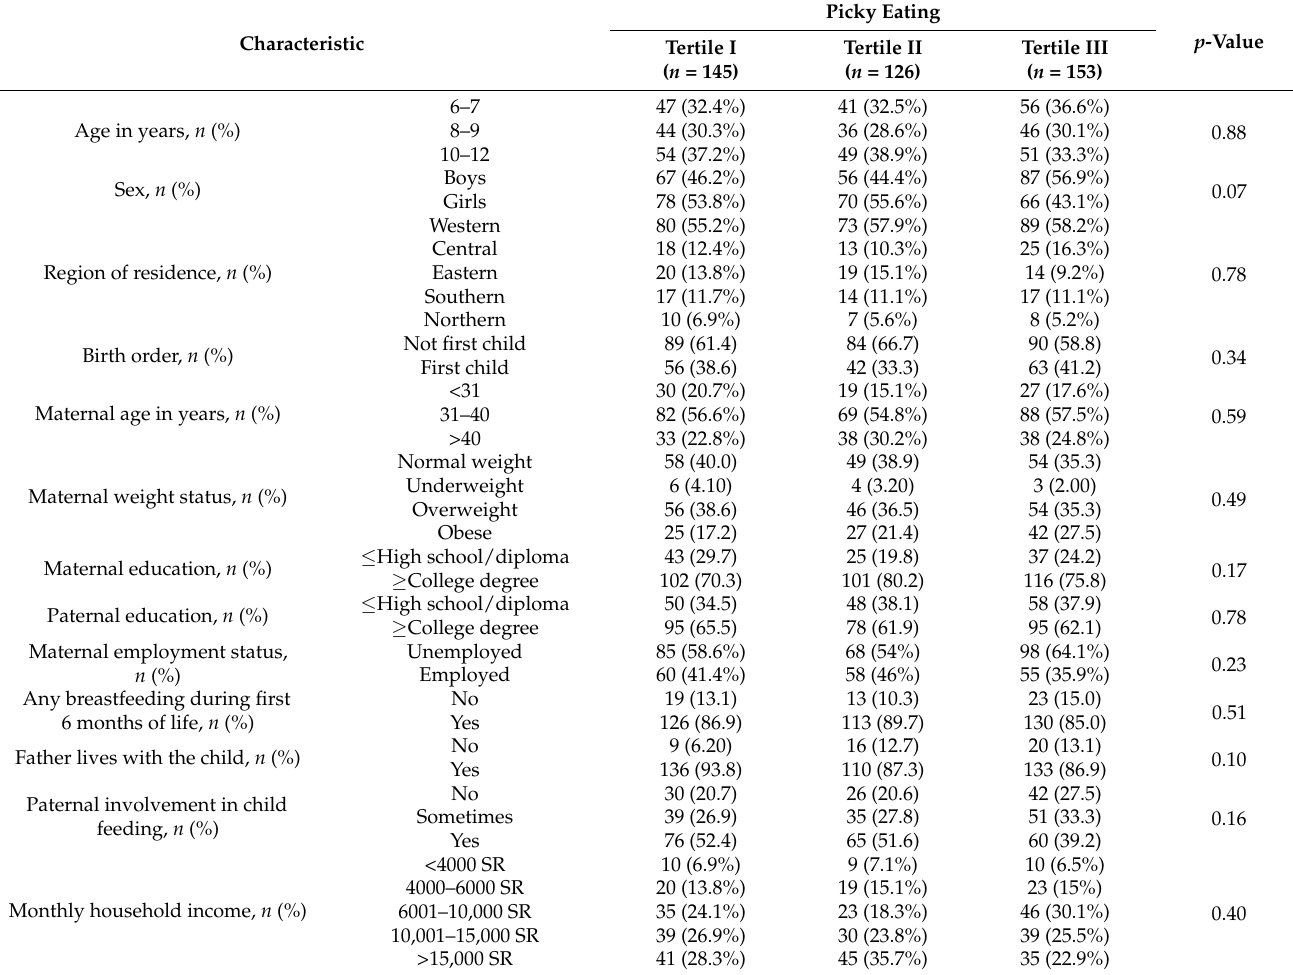
Table 1. Differences in characteristics of children among tertiles of picky eating ( n = 424) a .